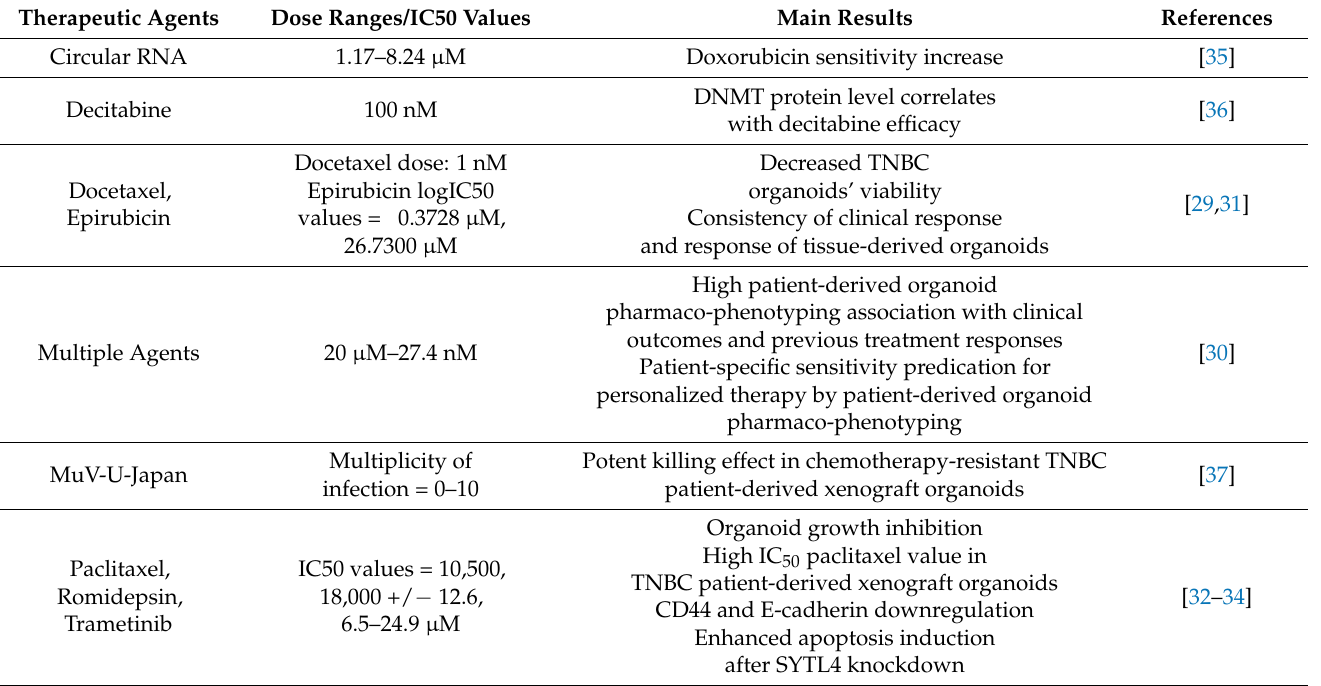
Table 1. The use of organoids for chemotherapy sensitivity testing in